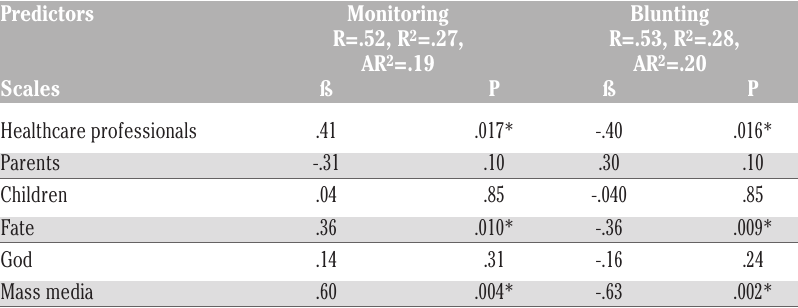
Table 4. Regression analysis outcomes concerning the effects of maternal locus of control on children’s coping